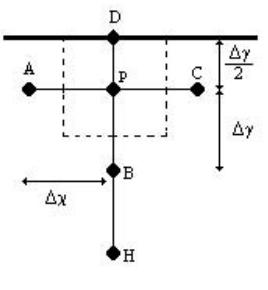
Figure 4: Boundary point.